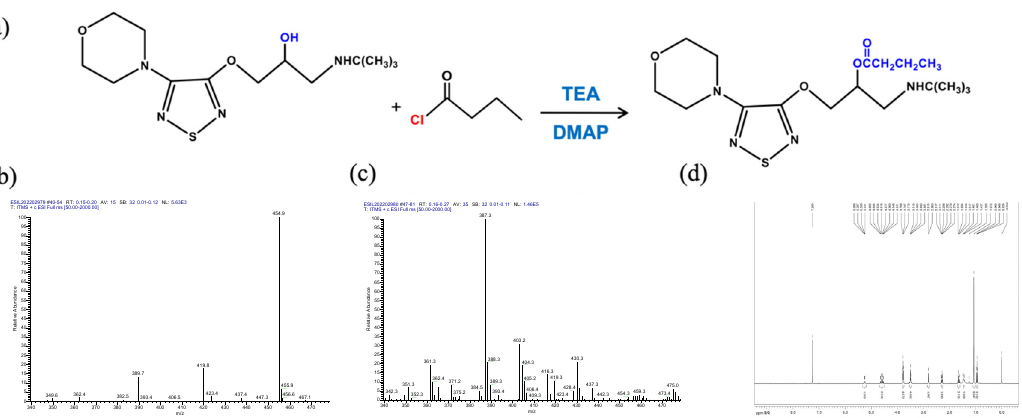
Figure 1. Synthesis and characterization of butyryl timolol (BT). ( a ) Diagram of BT synthesis; ( b ) ESI/MS of Timolol Maleate ™; ( c ) ESI/MS and ( d ) D500-MHz 1H NMR spectra of synthesized BT.